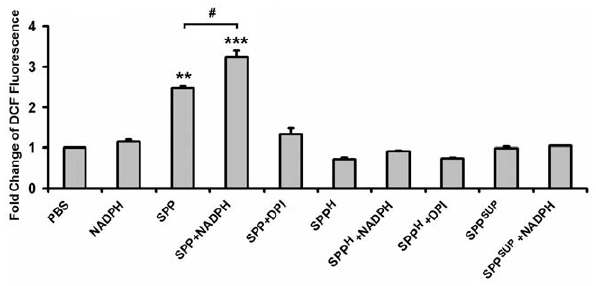
Figure 1. ROS generating capacity of freshly isolated SPPs. To determine ROS production by SPPs, H 2 DCF-DA, a redox-sensitive dye, was added to the SPP suspension and the changes in DCF fluorescence intensity were measured by fluorometry. To prove that ROS production was due to intrinsic NAD(P)H oxidases present in SPPs, controls containing heat-inactivated SPPs, the supernatant of the freshly isolated SPPs, NADPH, a substrate of NAD(P)H oxidases, and DPI, an NADPH oxidase inhibitor, were included. Data are presented as means 6 SEM of three individual experiments. ** p , 0.01; *** p , 0.001 vs PBS, # p , 0.05. (DCF: dichlorofluorescein; DPI: diphenyleneiodonium; SPP: subpollen